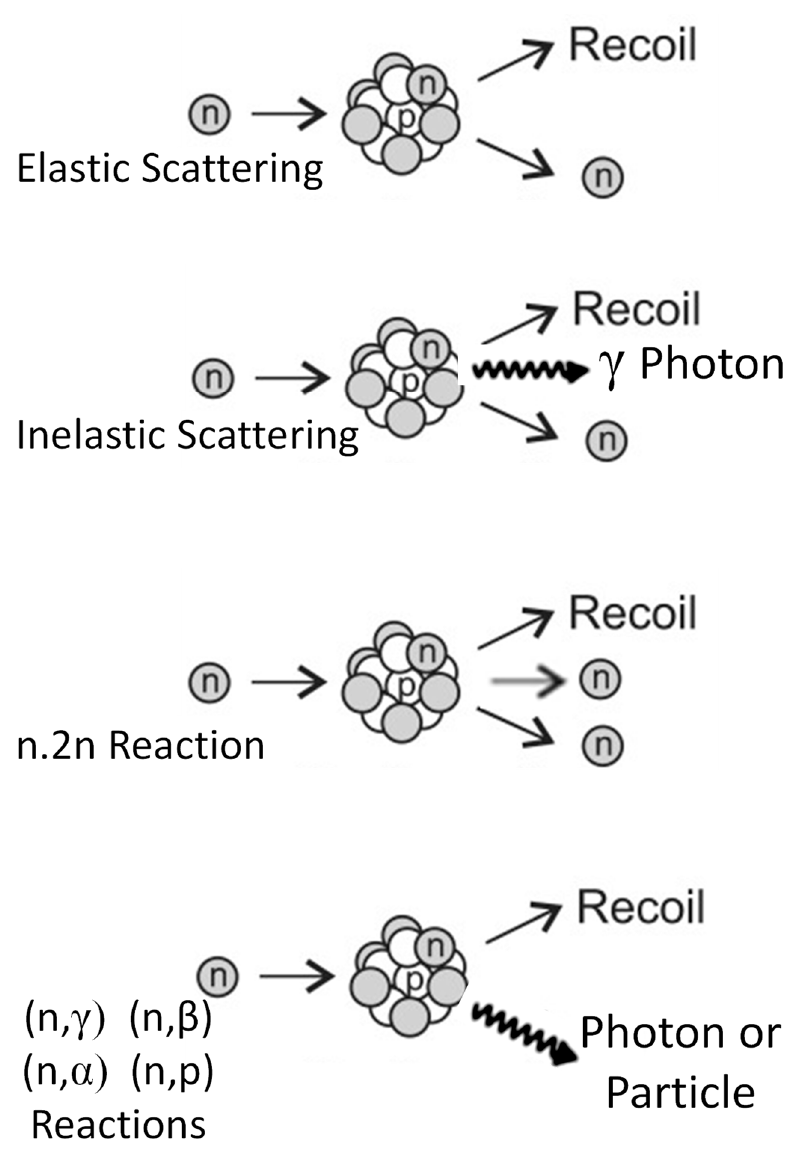
Figure 1. Schematic illustration of the main neutron-nucleus interactions that give rise to atomic displacements.